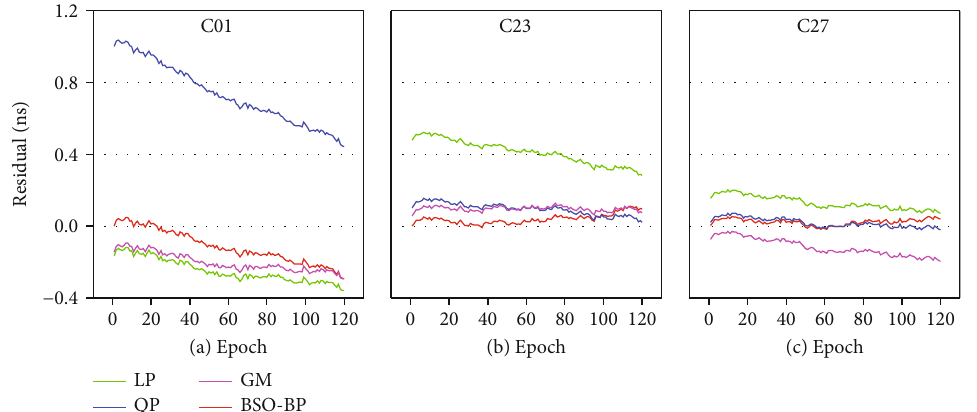
Figure 10: The residual plot of three satellites using 6 hours data to forecast 1 hour: (a) the residual value of C01 forecast 1 hour; (b) the residual value of C23 forecast 1 hour; (c) the residual value of C27 forecast 1 hour.